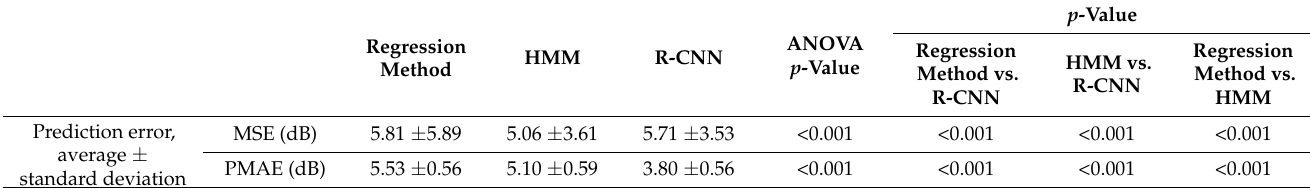
Table 6. Comparison of average MSE and P-value between regression method, HMM, and